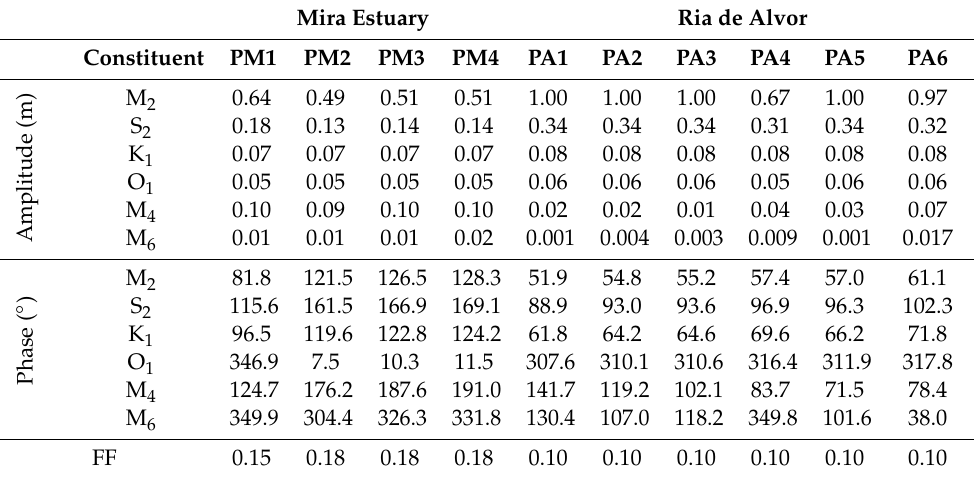
Table 3. Amplitude and phase of the main tidal constituents and Form Factor (FF) for Mira Estuary and Ria de